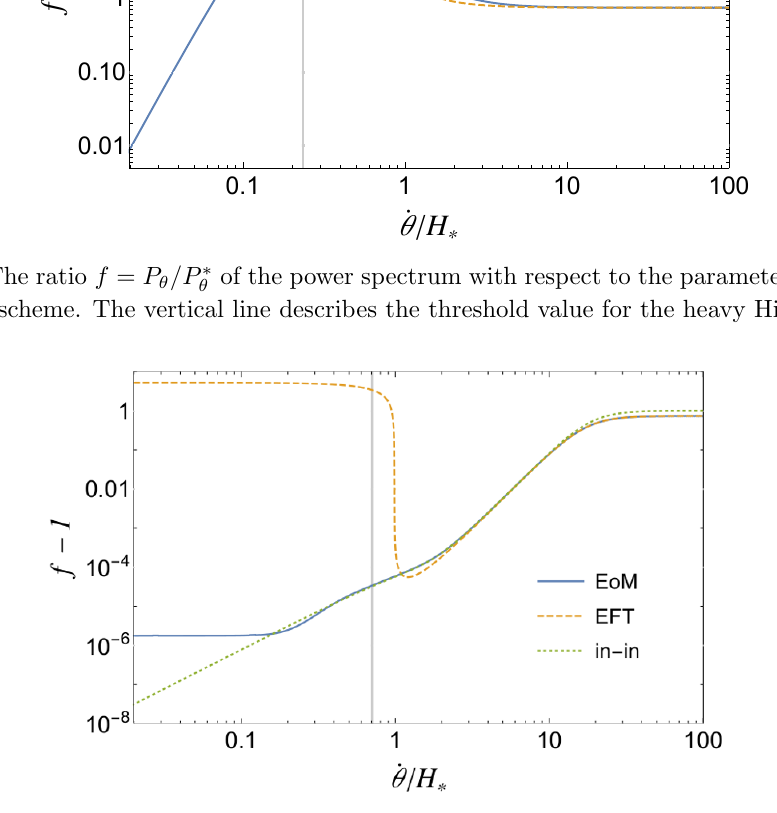
For both rescaling scheme, in the limit _ (cid:18) mode with negligible corrections to the power spectrum. For _ (cid:18) agree with the prediction from the e(cid:11)ective (cid:12)eld theory (EFT) method by integrating out the heavy Higgs (cid:12)eld. In the intermediate regime _ (cid:18) EoM method in the H -rescaling scheme cannot be explained by the analytical approach (in-in formalism) nor the EFT method. We remark that the numerical results shown in (cid:12)gures 4 and 5 do not diverge in the limit of m (cid:22) vanishes identically in this